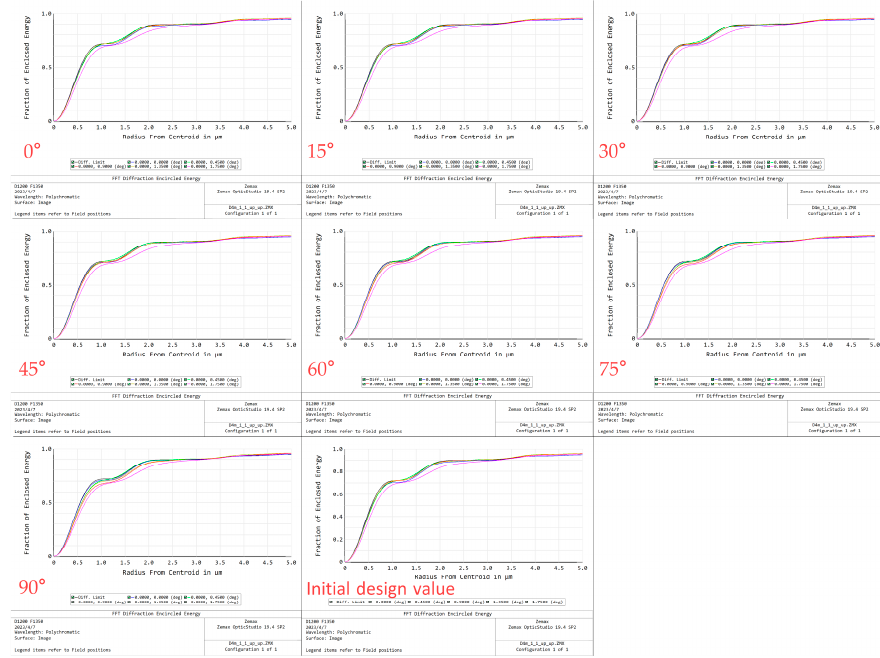
Figure 16. Imaging quality analysis (FFT diffraction encircled energy